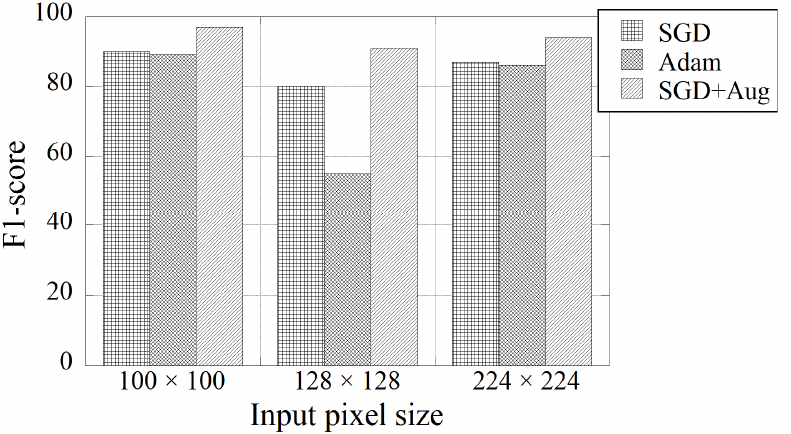
Figure 12. Training loss and accuracy of ShallowNet (SN), LeNet (LN), and MiniVGGNet (MVGGN) models.